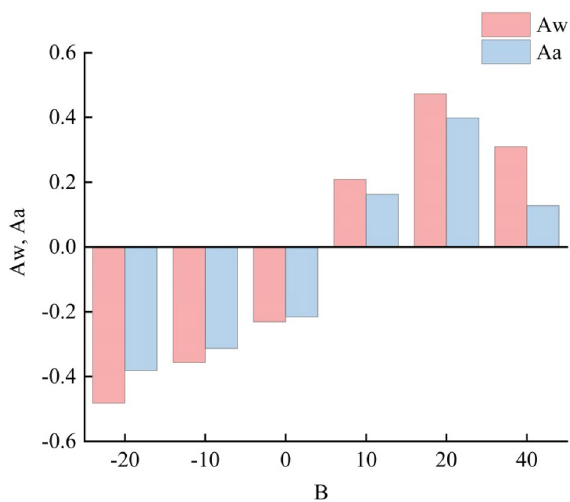
Figure 4. The asymmetry of different B values.